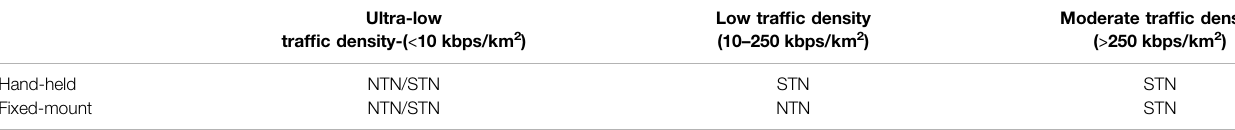
TABLE 5 | Ef fi cient choice of system for different rural scenarios considering DL traf fi